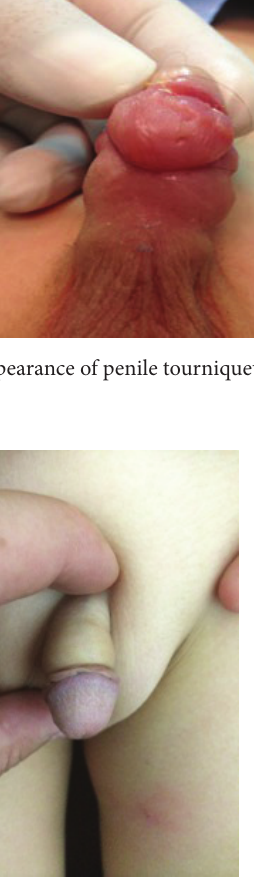
Figure 2: The appearance of penis at the third